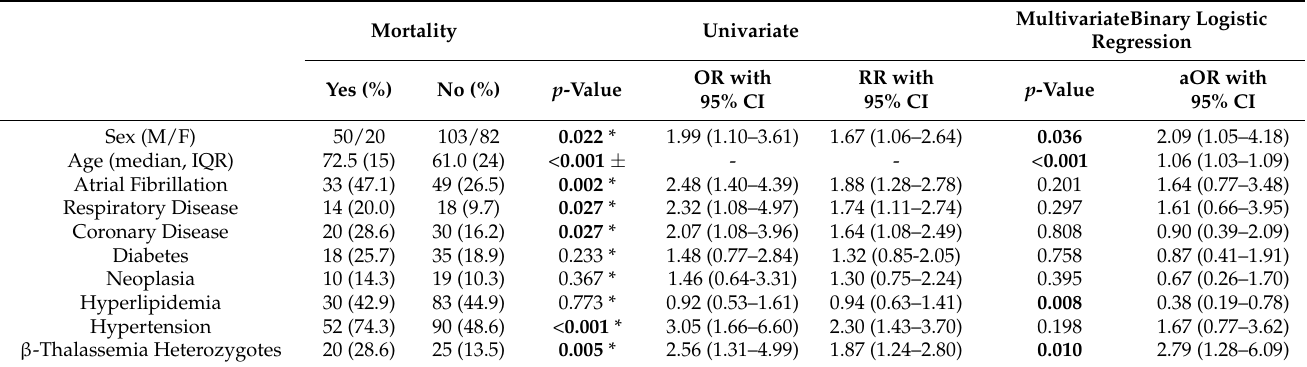
Table 2. Characteristics and mortality due to COVID-19.